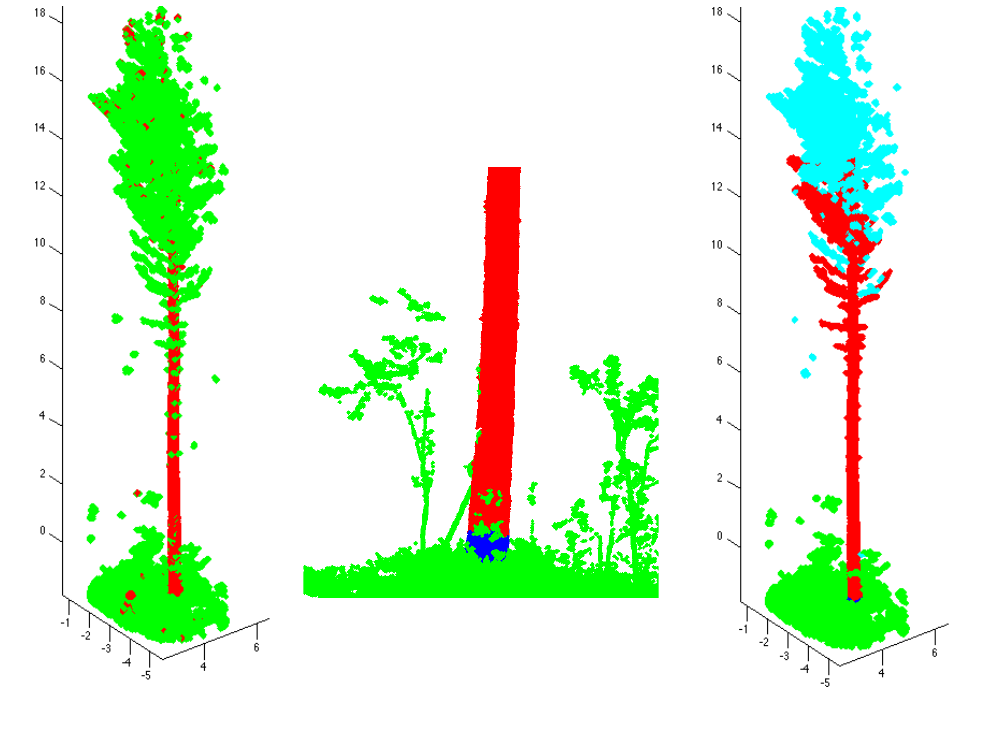
Figure 3. Determination of tree components and their bases. Left: The initial classification of trunk points (red). Middle: Part of the trunk point set (red) and its base (blue). The green denotes sets not part of the tree. Right: Final classification of components. The component starting from the base (red), the other tree components (cyan), and the points not part of the tree (green). The units of the axes in the left and right figure are